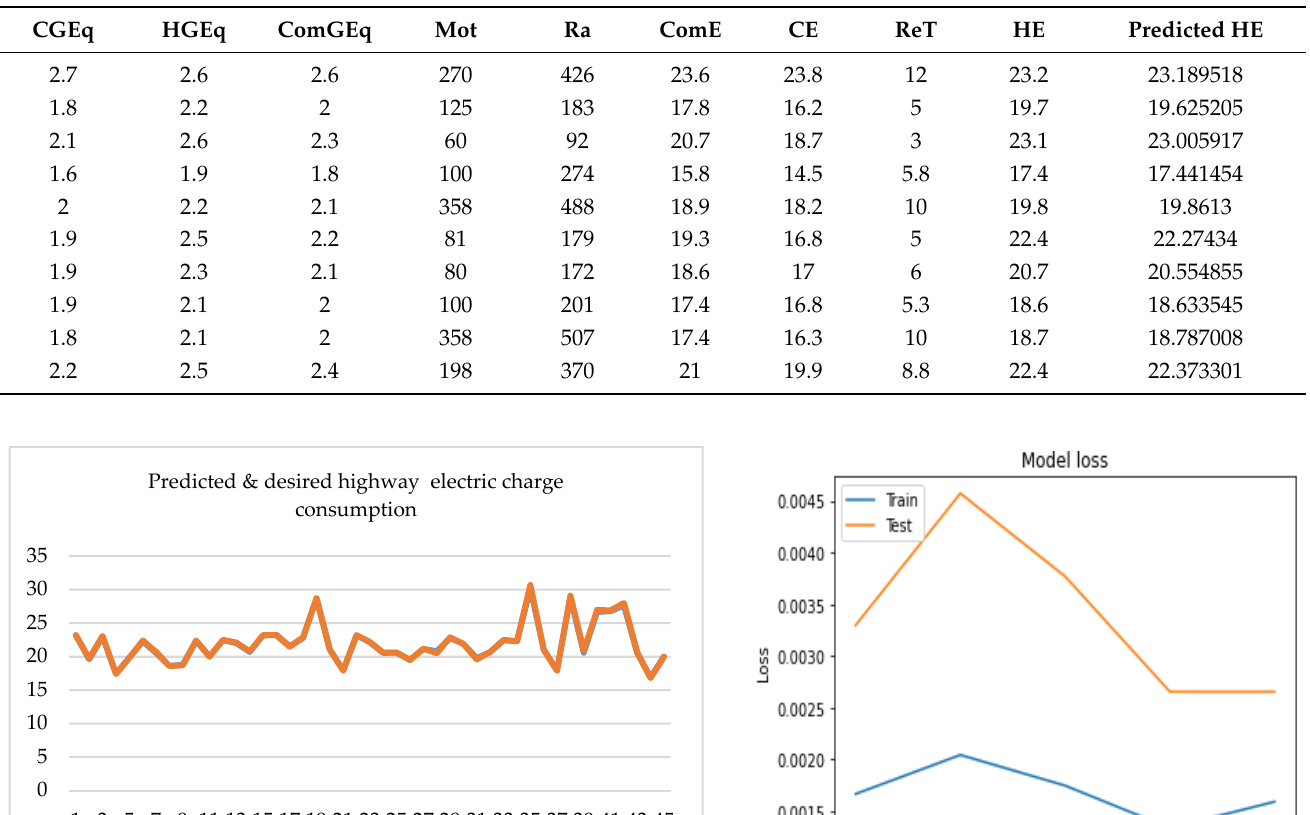
Table 5. Predicted and desired highway electric charge consumption.